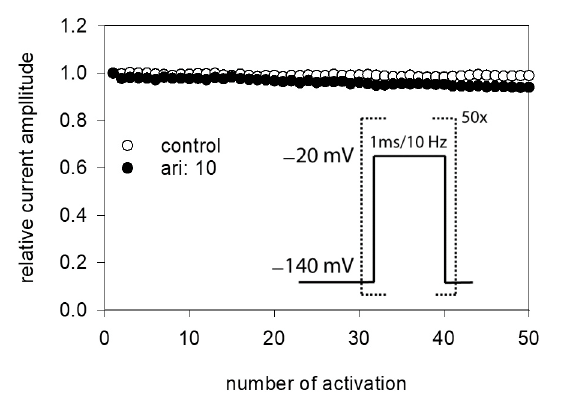
Figure 9. Analysis for use-dependence. Short activations (1 ms) were carried out at a frequency of 10 Hz in the absence and presence of 10 μ M aripiprazole. Current amplitudes declined under control from the first to the last activation (50th pulse) by 1.8 ± 1.1%. In the presence of aripiprazole (10 µ M), current reduction amounted to 8.2 ± 2.1%. Aripiprazole was preincubated for 20 s.